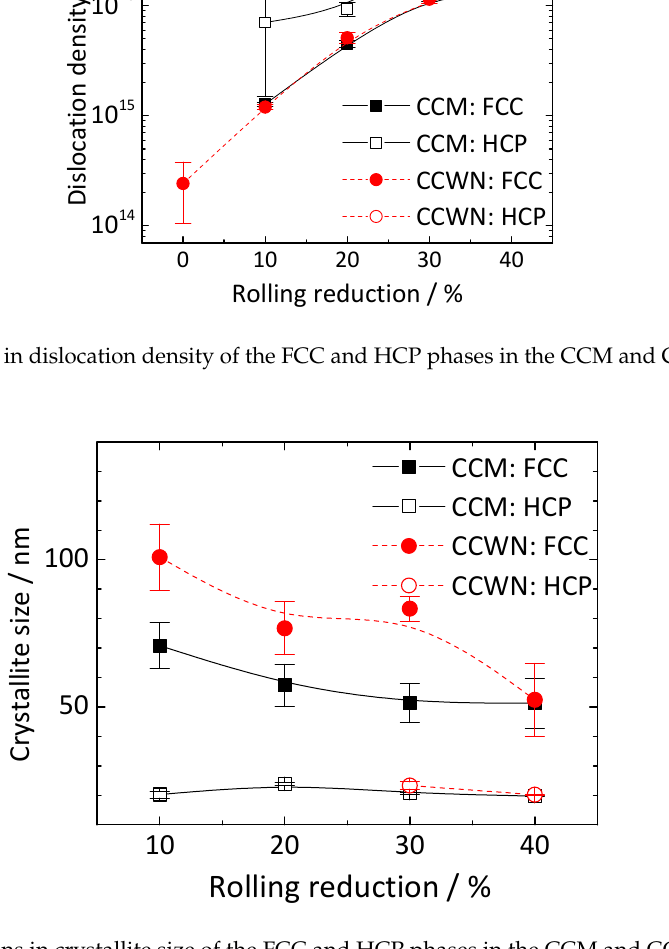
Figure 10. Variations in crystallite size of the FCC and HCP phases in the CCM and CCWN alloys.